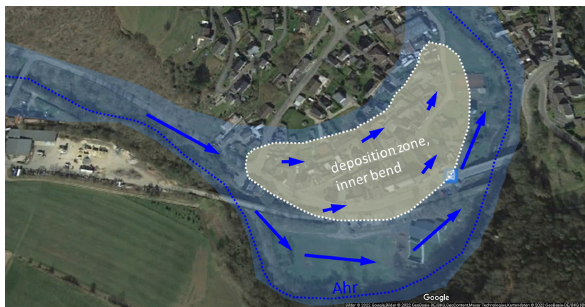
Figure 9. Inner bend deposition in the municipality of Schuld (© Google Earth,